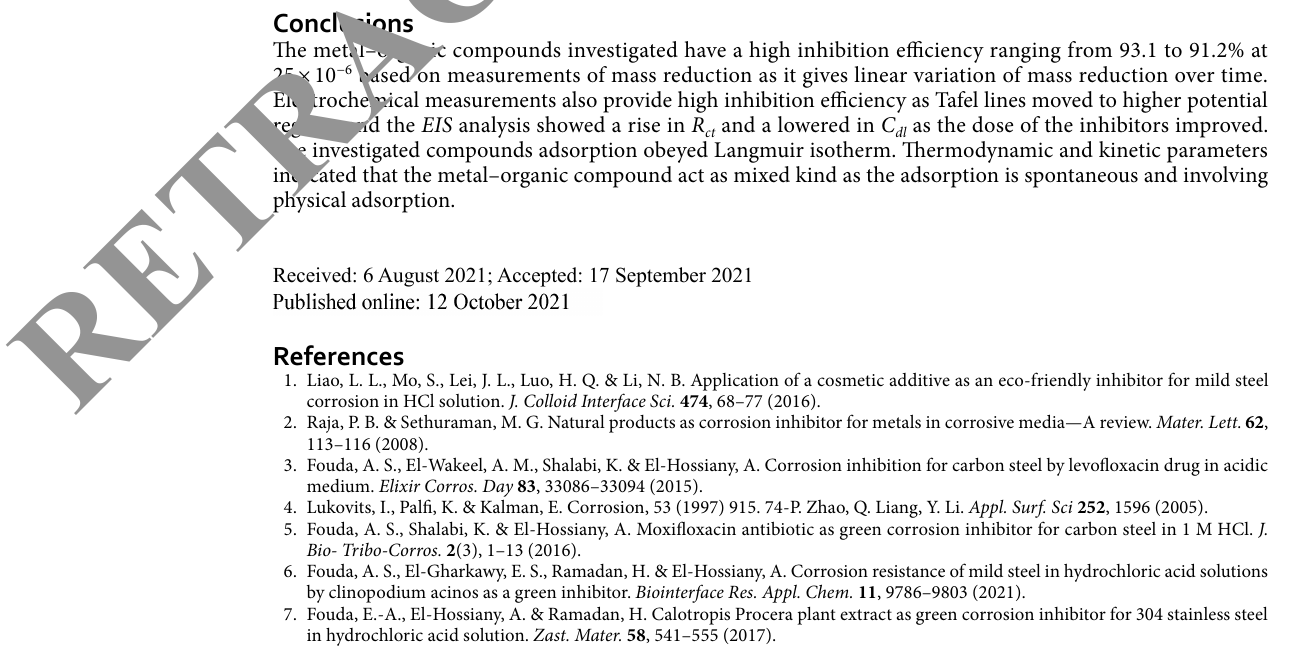
Figure 14. Mechanism of